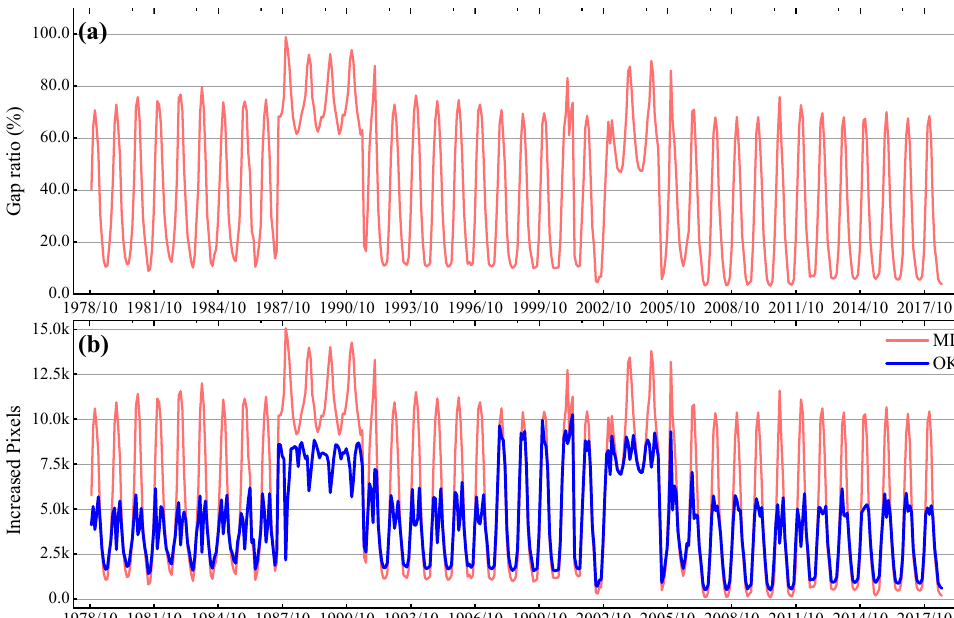
Figure 3. ( a ) The data gap ratios in original CCI SM and ( b ) the increased pixels by ML and OK gap-filling methods during the whole study period.